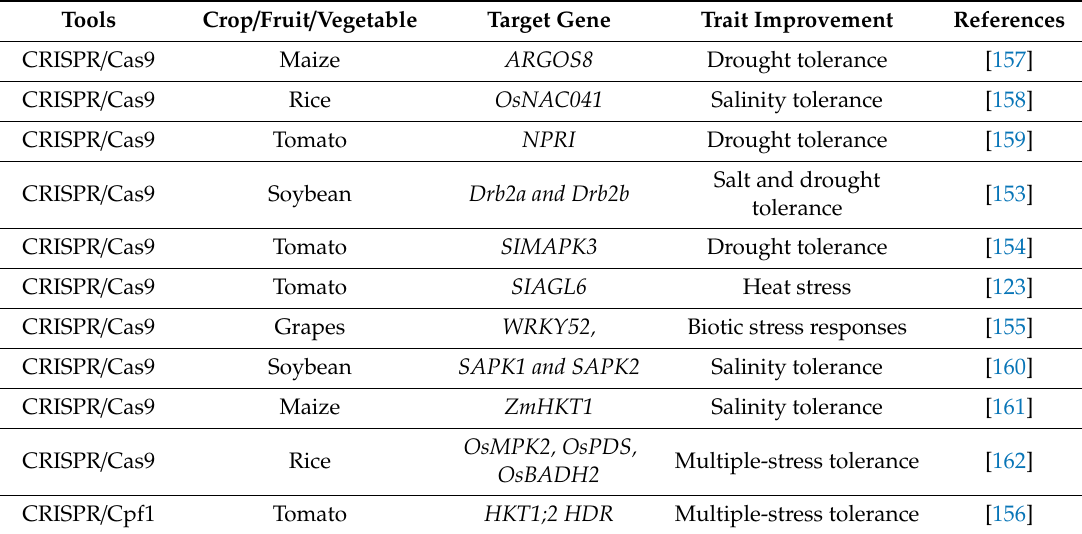
Table 4. Improvement of climate-resilient crops, vegetables, and fruits by CRISPR / Cas9 / Cpf1. Tools Crop / Fruit /